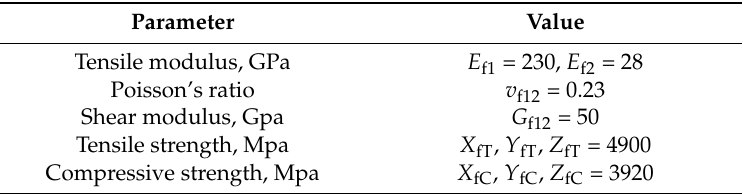
Table 1. The mechanical properties of fiber carbon.